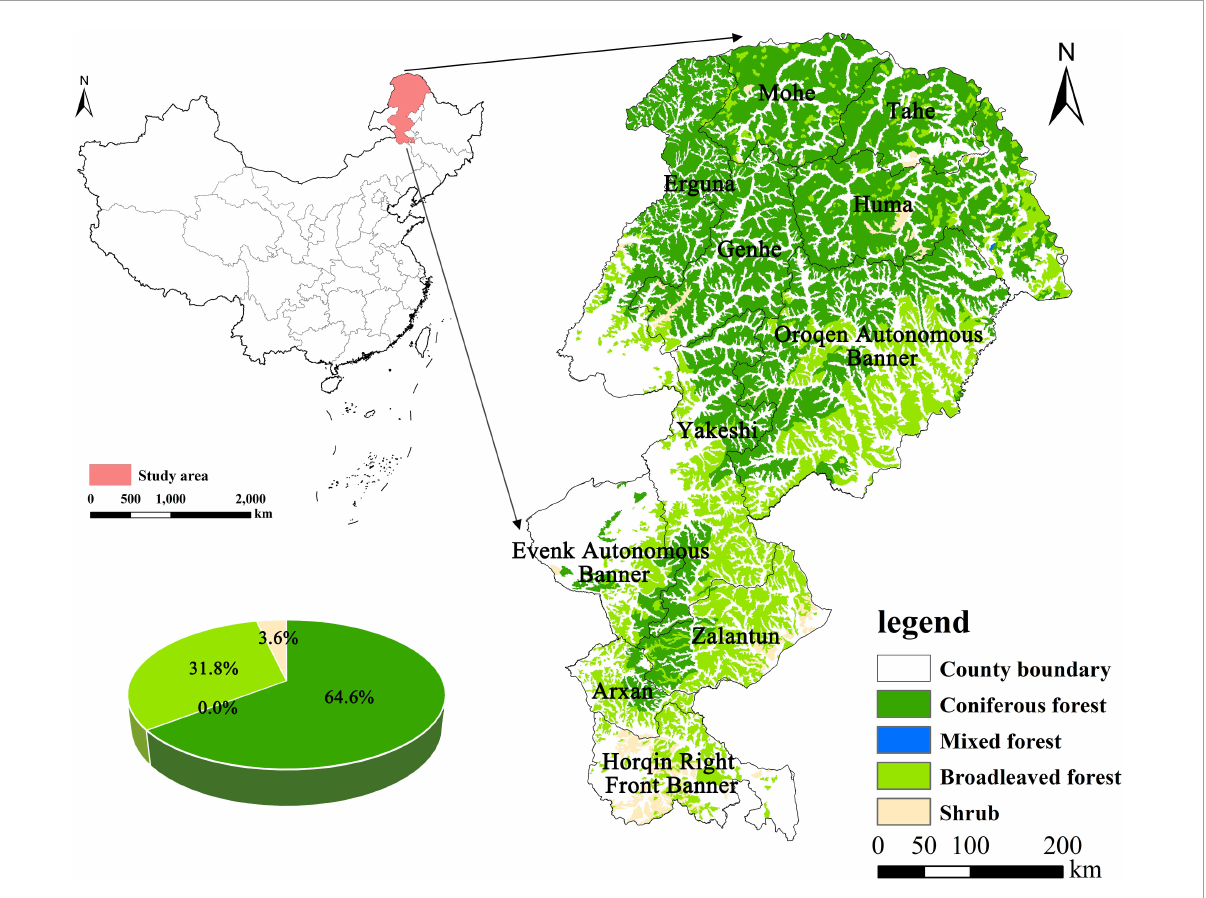
FIGURE1 Location, forest types, and their percentages of the study